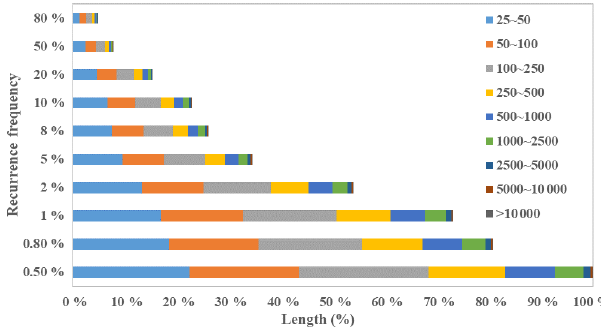
Figure 4. The length percentages in different width ranges at dif- ferent recurrence frequencies for